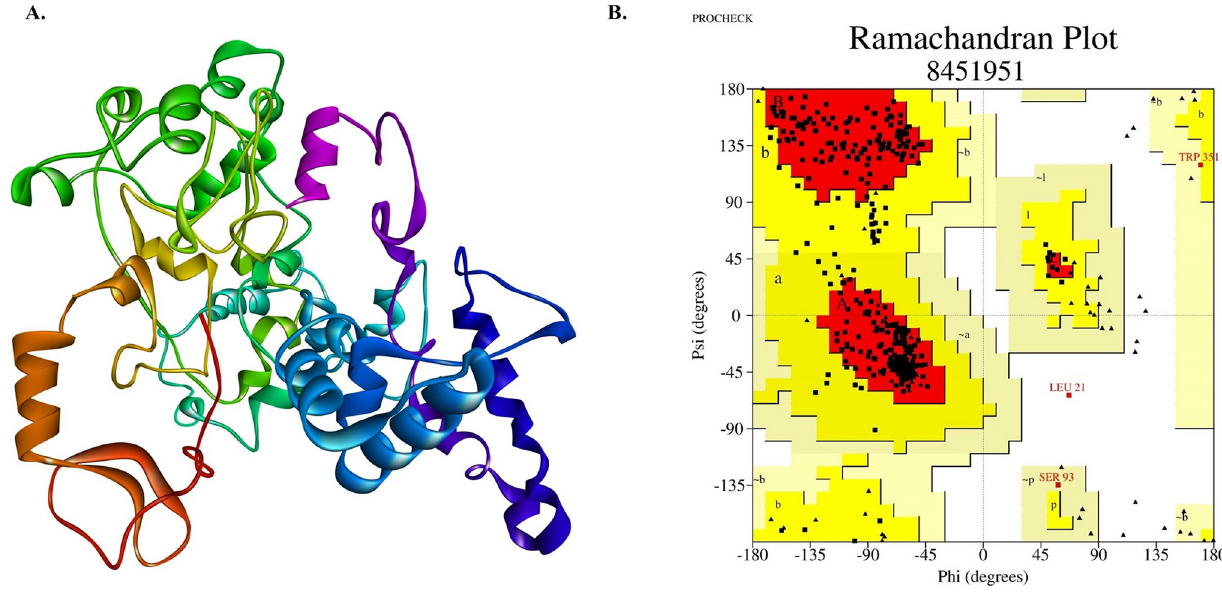
Fig 6. Tertiary structure and Ramachndran plot assessment of the refined vaccine protein. a) Model-5 from Robetta server (Homology modelling server) after refinement; b) Ramachandran plot analysis of refined vaccine protein by PROCHECK server. Refined model contains 88.1% residues in most favored region, 5.3% residues in additionally allowed region, 0.5% in generously allowed region and only 0.3% in disallowed region.